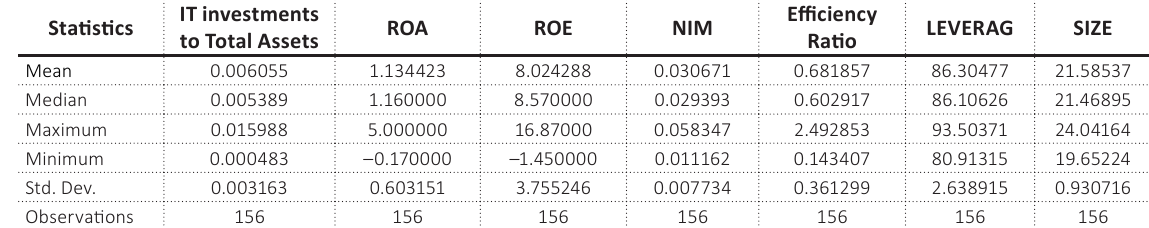
Table 4. Summary